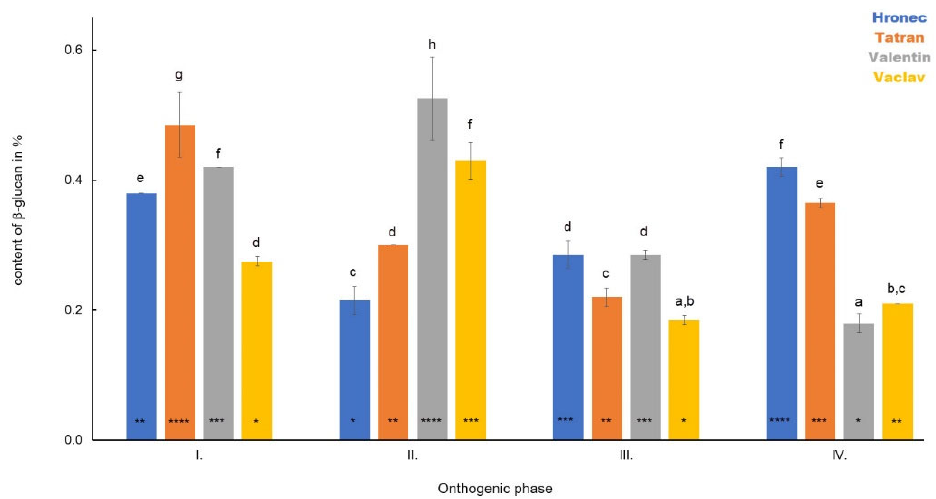
Figure 2. The dynamics in the content of β‐ D ‐ glucan in stems of four analysed oat varieties during plant development. Different letters indicate a statistically significant difference between individual varieties in specific ontogenetic phase evaluated by ANOVA (LSD, p ≤ 0.05). Star symbols (*, **, ***, and ****) represent statistically significant difference between four varieties evaluated for each monitored ontogenetic phase individually by ANOVA (LSD, p ≤ 0.05).